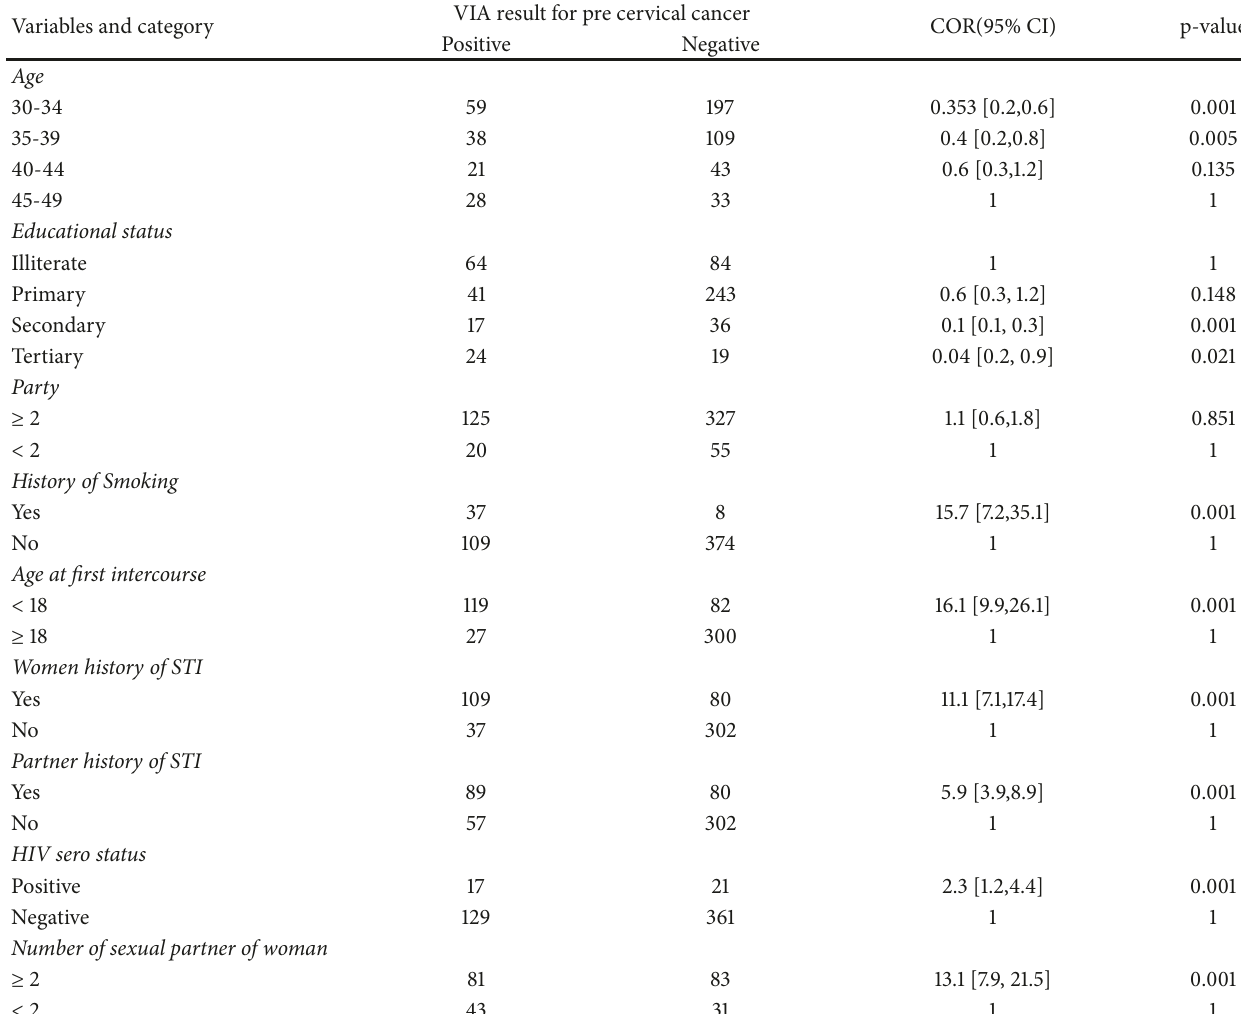
Table 3: Binary logistic regression analysis showing factors associated with precervical cancer among screened women at Arba Minch town and zuria district, Gamo Gofa zone, SNNPR, Ethiopia,